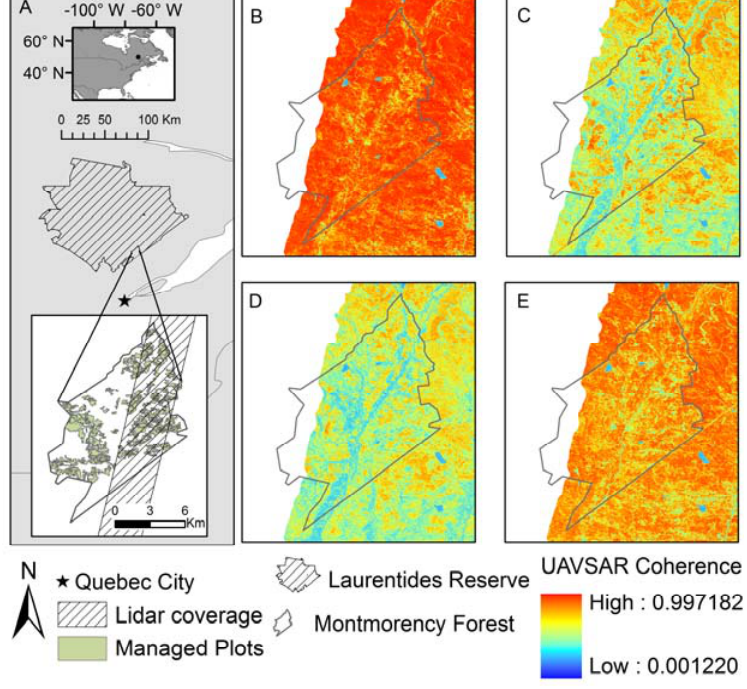
Figure 1. Study site in Quebec, Canada. ( A ) Overview of study site in Montmorency Forest. UAVSAR coherence is shown with temporal baselines of 45 min ( B ), 2 days ( C ), 7 days ( D ), and 9 days ( E